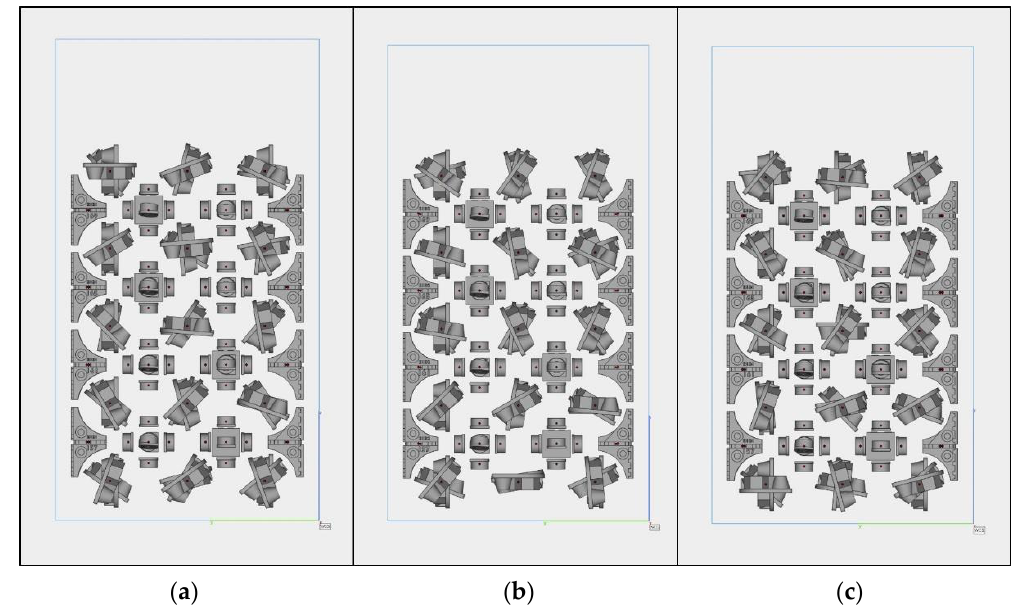
Figure 13. Build layout in Magics 23.01 for all three builds as seen from the left. ( a ) Build 1; ( b ) build 2; ( c ) build 3.